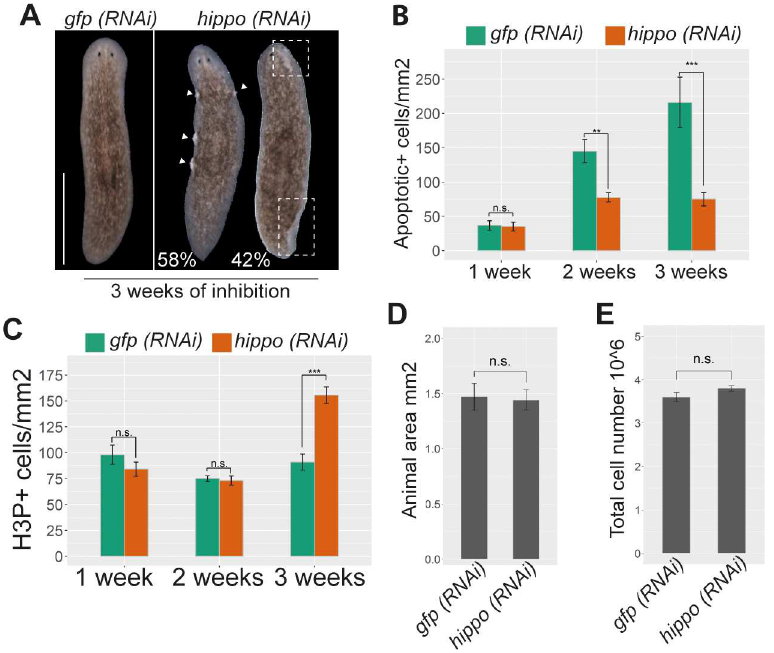
Fig 1. Inhibition of hippo in planarians decreases apoptosis and increases mitotic rates but does not affect cell number. (A) Stereomicroscopic image of live hippo (RNAi) planarians showing the overgrowths and unpigmented regions in marginal regions of the body ( n = 30). White arrows indicate overgrowths and white discontinuous boxes indicate unpigmented regions. (B) Quantification of apoptotic cells (TUNEL+) after 1, 2, and 3 weeks of hippo RNAi ( n (cid:21) 5). (C) Quantification of mitotic cells (H3P+) after 1, 2, and 3 weeks of hippo RNAi ( n (cid:21) 10). (D) Quantification of body area in planarians subjected to 3 weeks of hippo RNAi, as compared with controls ( n (cid:21) 8). (E) Graph showing the total cell number in planarians subjected to 3 weeks of hippo RNAi, as analyzed by FACS. Bars correspond to the mean of 3 biological replicates. Data used in the generation of this figure can be found in S1 Data. Error bars represent standard deviation. Data were analyzed by Student t test. (cid:3)(cid:3) p < 0.01; (cid:3)(cid:3)(cid:3) p < 0.001. FACS, fluorescence-activated cell sorting; gfp , green fluorescent protein ; H3P, phospho-histone-H3-Ser10; n.s., not significant; RNAi, RNA interference.